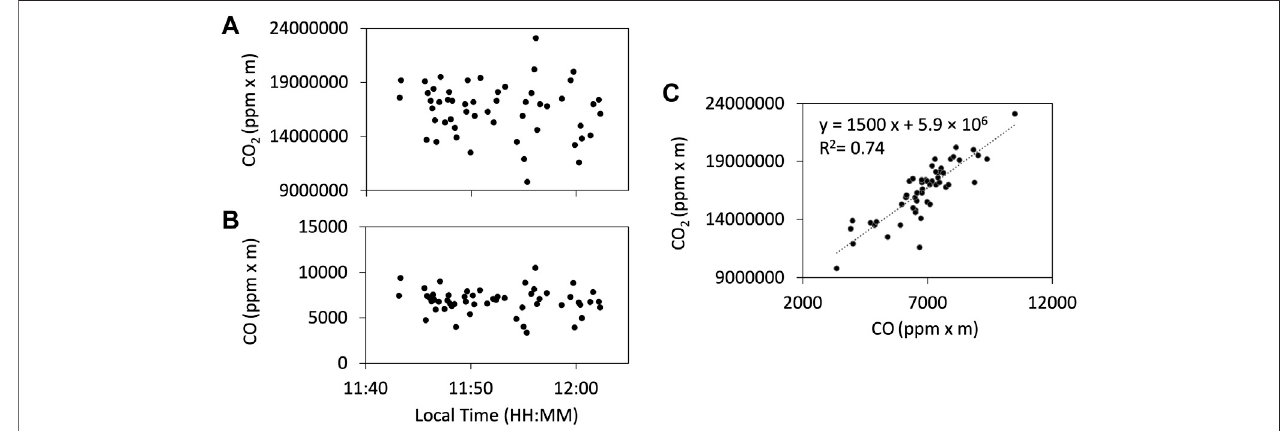
FIGURE7| Results oftheFTIR observation ofCOusing thelavalakeasthelightsourceon12January2018.Column amount timelines ofCO 2 (A) andCO (B) . (C) The correlation plot of the CO 2 and CO column amounts. The CO 2 /CO ratio is estimated to be ca. 1,000.